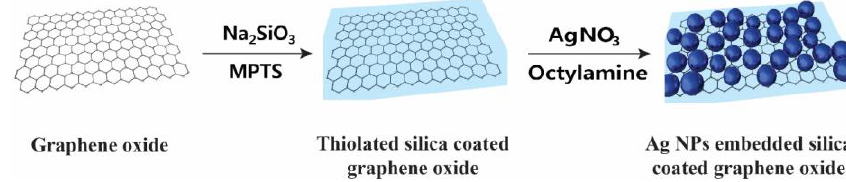
Figure 1. Synthesis of silver nanoparticle-embedded silica-coated graphene oxide.